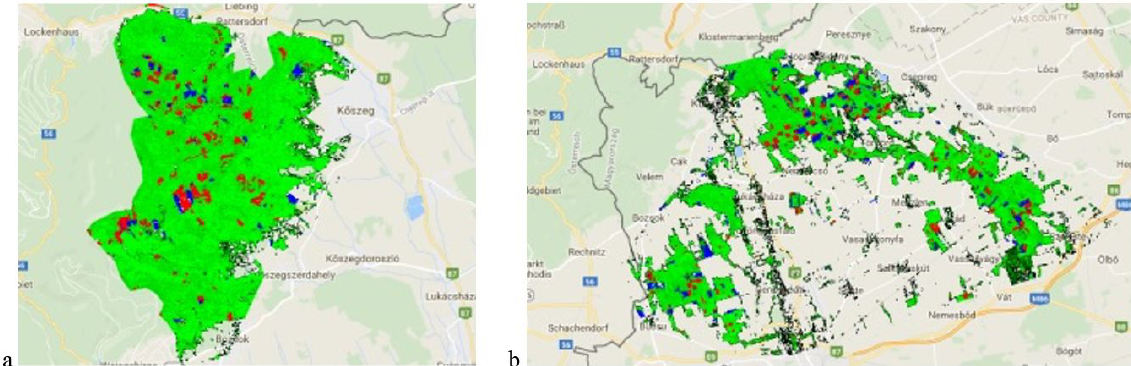
Figure 3. (a) Net Forest Change, Western Watershed (b) Net Forest Change, Eastern